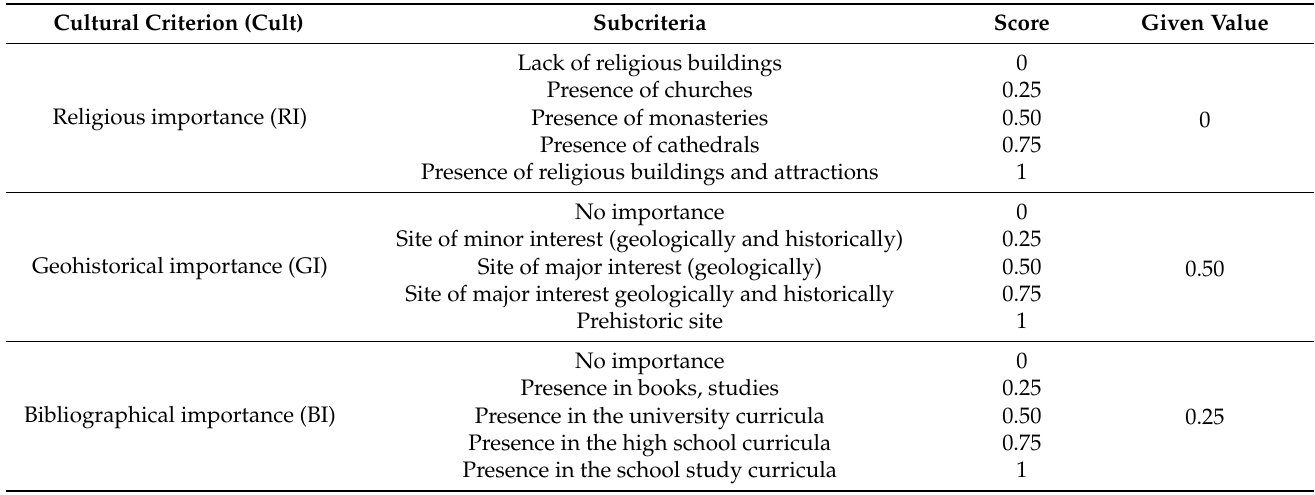
Table 3. Geomorphological value—the cultural criterion